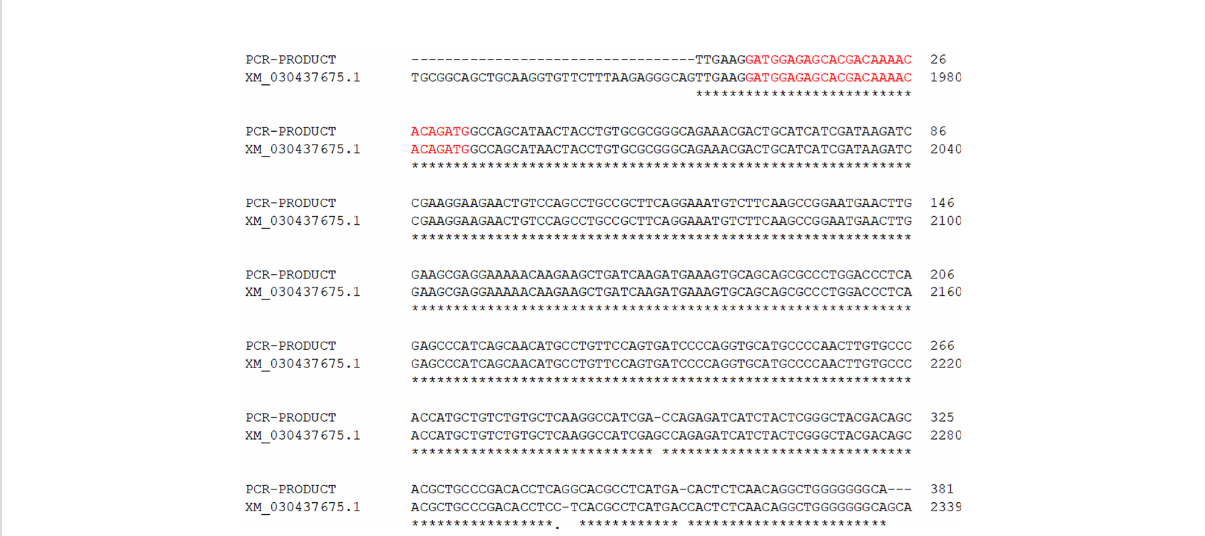
FIGURE 2 Multiple alignment for the sequence obtained from our puri fi ed PCR product and the sequence with the highest match obtained from BLAST analysis. The alignment for the DNA-binding region is presented for the PCR product (381-bp) and the sequence XM_030437675.1 (from 1955- to 2336-bp). A 99% identity is obtained (378/383-bp) between both sequences. In red is represented the 27-nucleotide insertion in the DNA- binding region and characteristic of the gr1 sequence. The "*" (asterisk) indicates positions which have a single, fully conserved residue. The "." (period) indicates conservation between groups of weakly similar